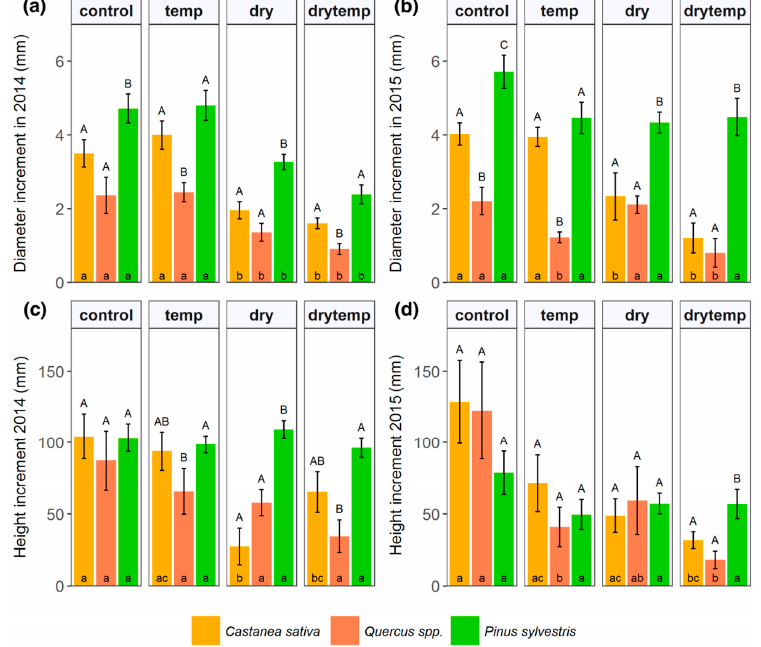
Figure 2. Diameter ( a , b ) and height ( c , d ) increments for both treatment periods 2014 ( a , c ) and 2015 ( b , d ). Bars represent mean ± SE. Upper and lowercase letters represent inter- and intraspecific significant differences ( p < 0.05) within and between treatments, respectively.